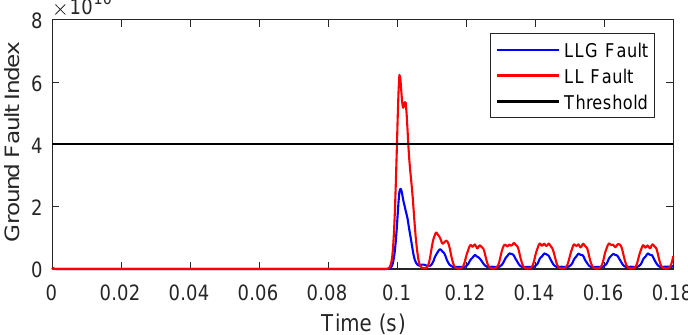
Figure 7. Differentiation among the LL and LL-G faults using the